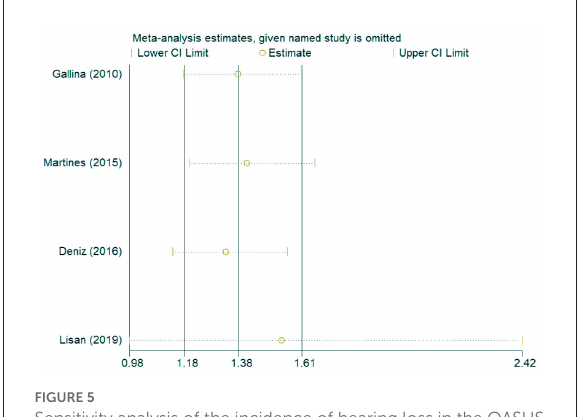
FIGURE5 Sensitivity analysis of the incidence of hearing loss in the OASHS group and the control group.